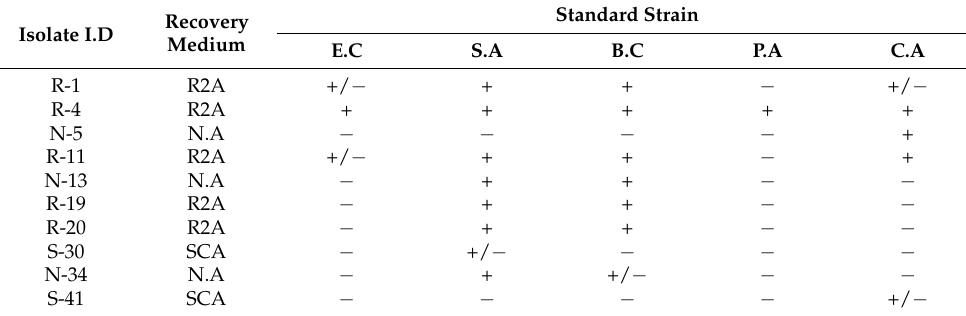
Table 2. Results of the positive microbial antagonism isolates.